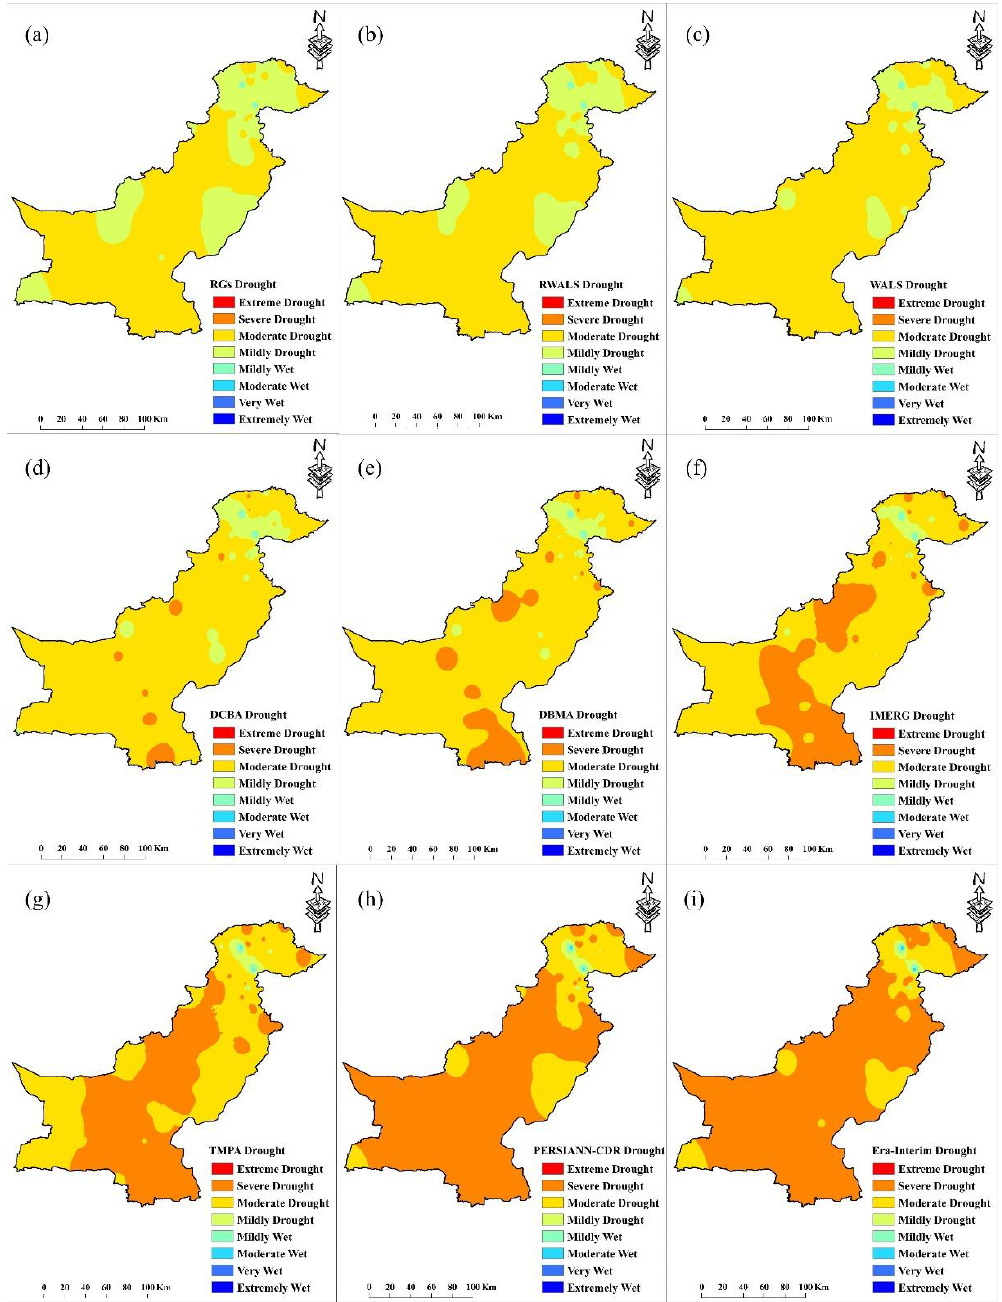
Figure 4. Spatial distribution drought (SPI-3) across Pakistan during winter season in the representative drought year (2008), ( a ) RGs, ( b ) RWALS-MSPD, ( c ) WALS-MSPD, ( d ) DCBA-MSPD, ( e ) DBMA-MSPD, ( f ) IMERG, ( g ) TMPA, ( h ) PERSIANN-CDR, and (i) ERA-Interim.